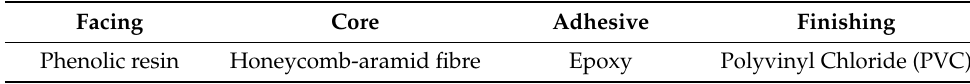
Table 5. Materials used for the interior components.